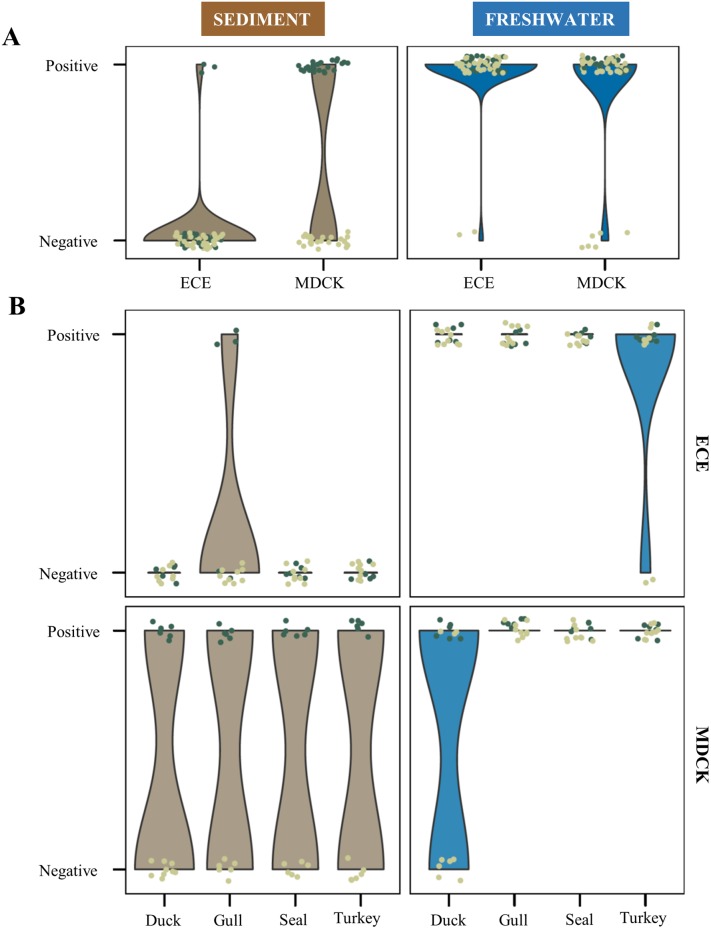
Recovery of influenza A viruses from inoculated sediment and freshwater samples with embryonated chicken eggs (ECE) and Madin-Darby Canine Kidney (MDCK) cells.Panel A graphs show all raw data points including each replicate and their distribution separated by sample type (water compared to sediment) and cultivation method (embryonated chicken eggs compared to MDCK cells). Panel B graphs show the same comparisons but separated by strain. Dark green circles represent samples with infection doses ≥ 100 PFU and light green < 100 PFU. Culture positive or negative data points are indicated on the y-axis. Results of sediment samples are shown in the left panels and of freshwater samples on the right. Influenza A strains are indicated on the x-axis.